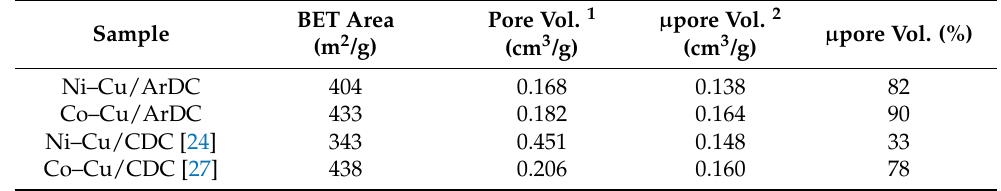
Table 1. Textural properties of the fresh